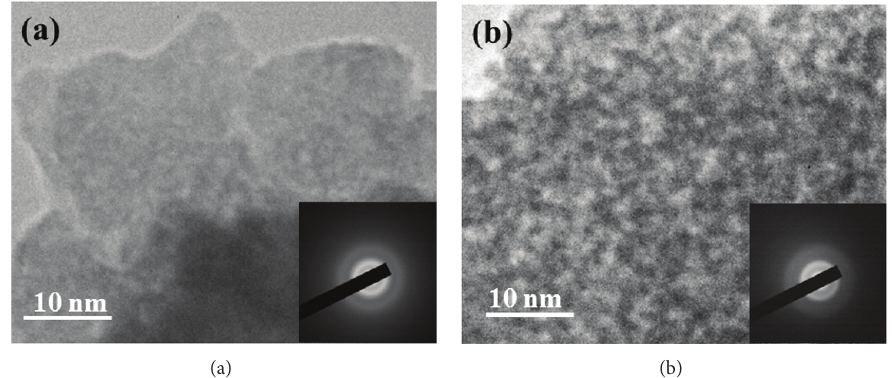
Figure 1: TEM images of dense Nb 2 O 5 film (a) and porous Nb 2 O 5 film (b) prepared with the ratio of PE6100 :NbCl 5 equal to 0.07 : 1. SAED diffraction patterns are shown as insets.